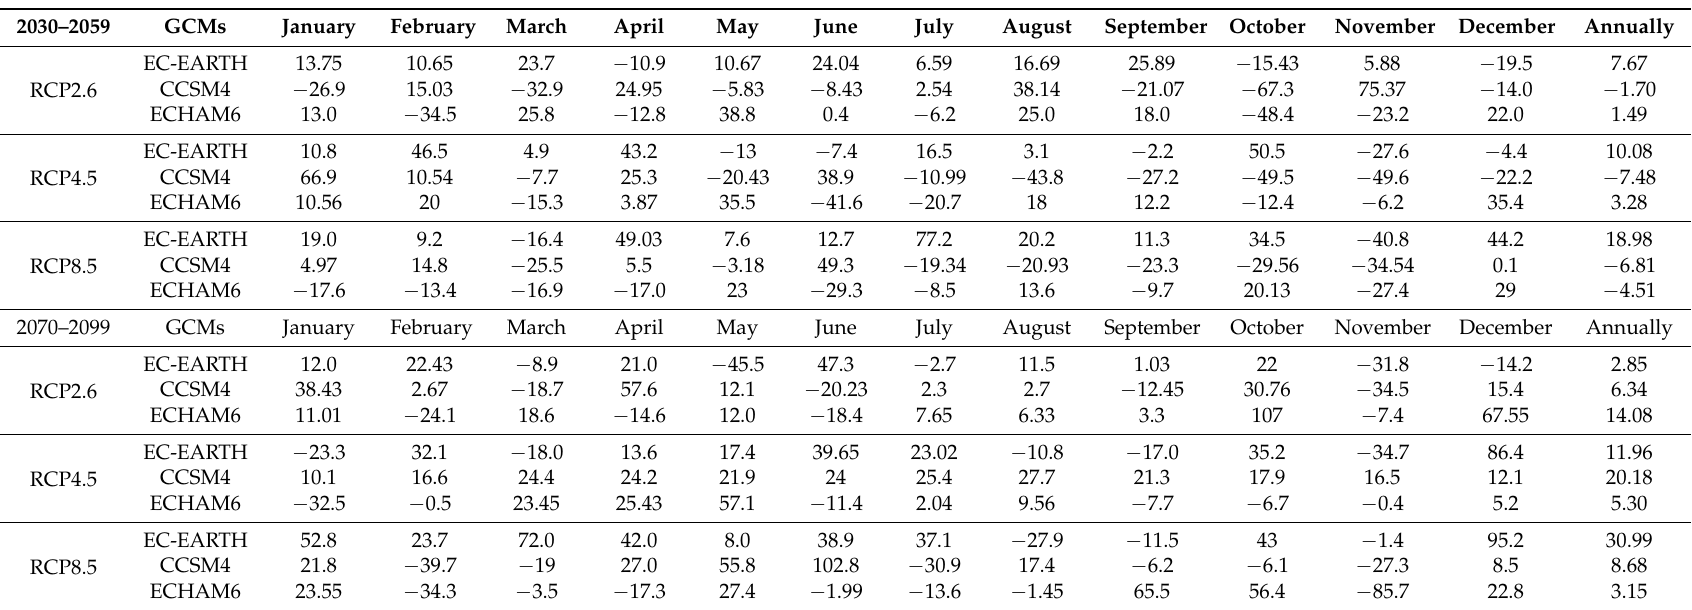
Table 9. Monthly precipitation variation (%) against the control period for our future reference